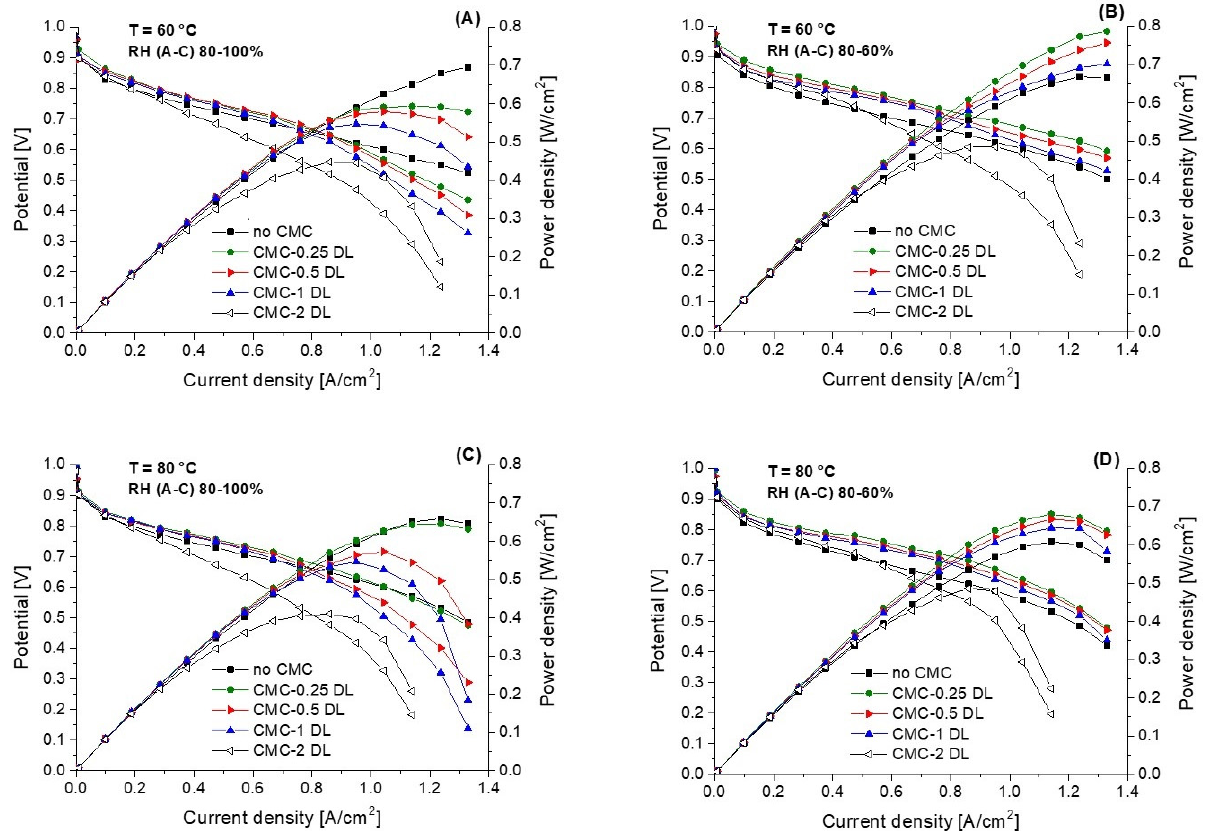
Figure 4. Polarization curves obtained at ( A ) 60 °C and RH (A-C) 80–100%, ( B ) 60 °C and RH (A-C) 80–60%, ( C ) 80 °C and RH (A-C) 80–100%, ( D ) 80 °C and RH (A-C) 80–60%.